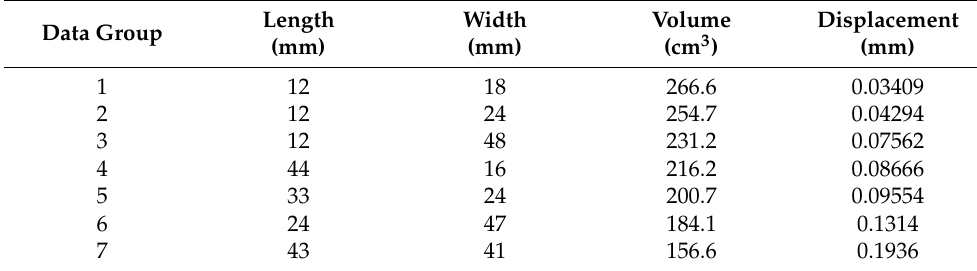
Table 3. Numerical results based on the HAS for the W-type